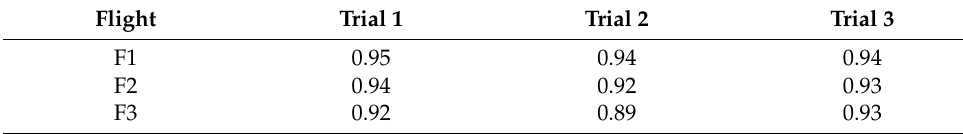
Table 7. LED Subsystem